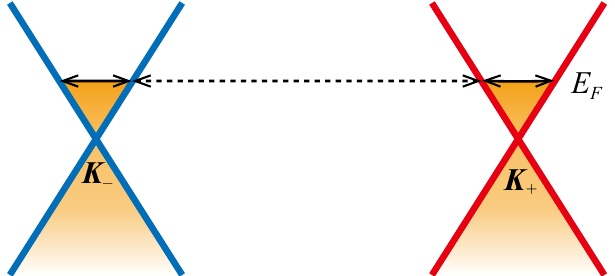
Figure 6. Schematic diagram of internode scattering represented by the dashed arrow and intranode scattering represented by the solid